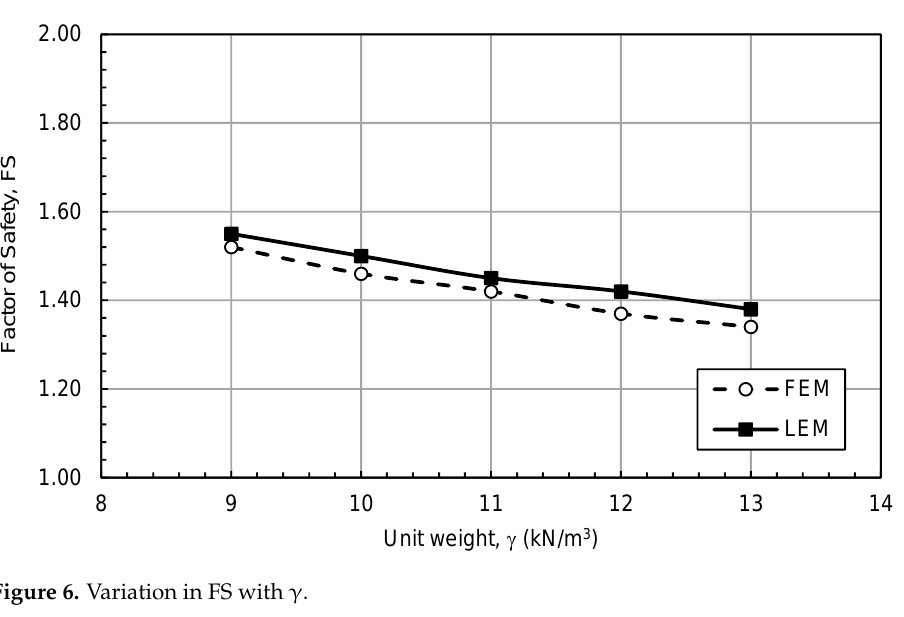
Table 4. Analysis results for different unit weight values